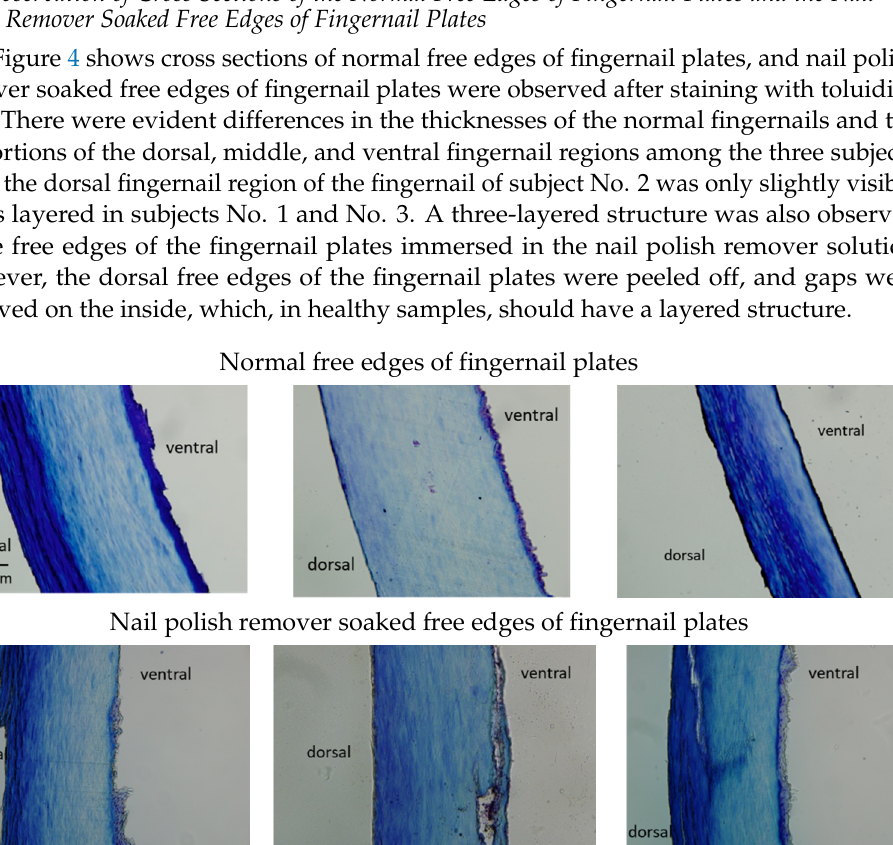
Figure 3. Ceramide content of the normal free edges of fingernail plates and the nail polish remover soaked free edges of fingernail plates measured by HPLC. n = 3, means ± standard deviations, *: p < 0.05.